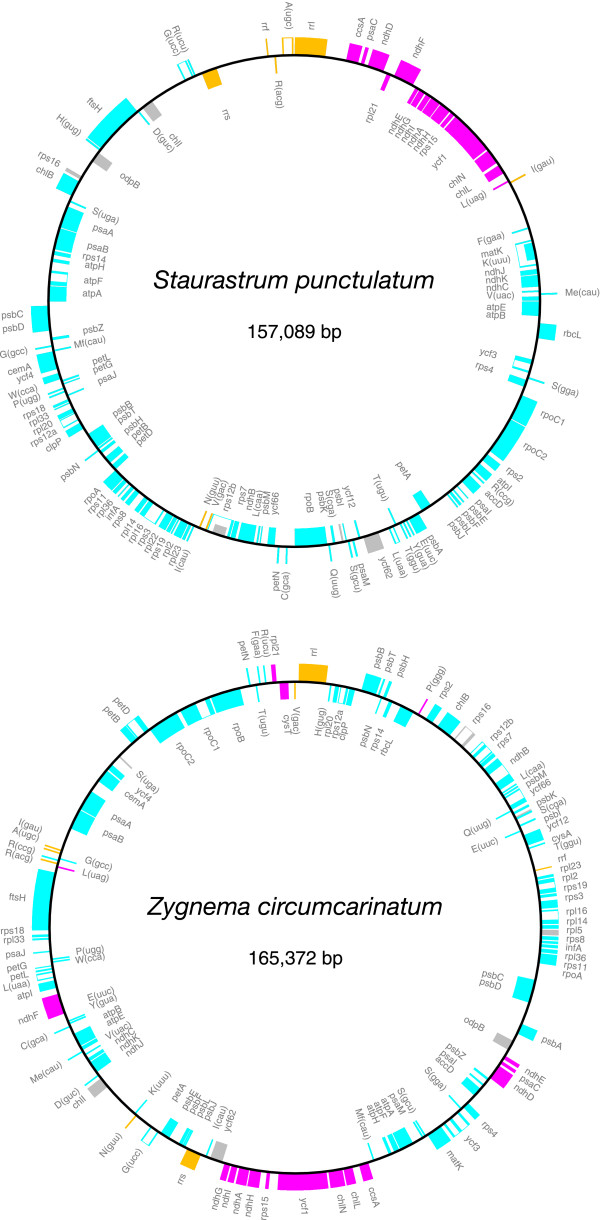
Compared patterns of gene partitioning in zygnematalean and Marchantia cpDNAs. Each gene in Staurastrum and Zygnema cpDNAs is colour-coded according to the region of Marchantia cpDNA [GenBank:NC_001319] carrying its homologue; cyan, large single-copy region; magenta, small single-copy region; and yellow, IR. Genes shown in grey are absent from Marchantia cpDNA.